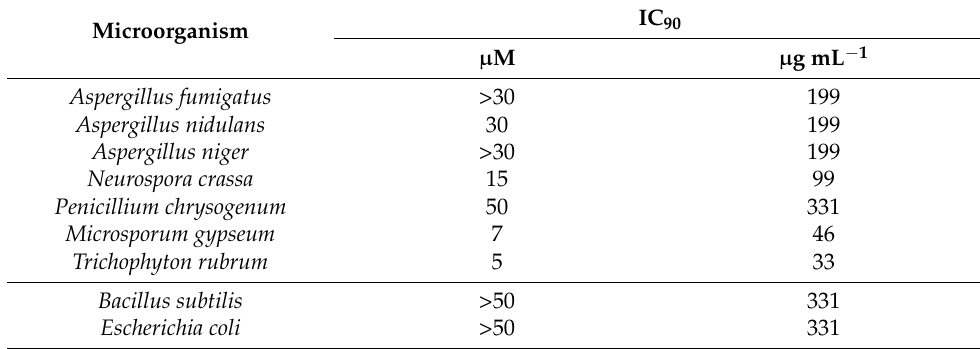
Table 3. PAFC inhibitory concentrations that reduce the growth of microorganisms by ≥ 90% (IC 90 ) $ .